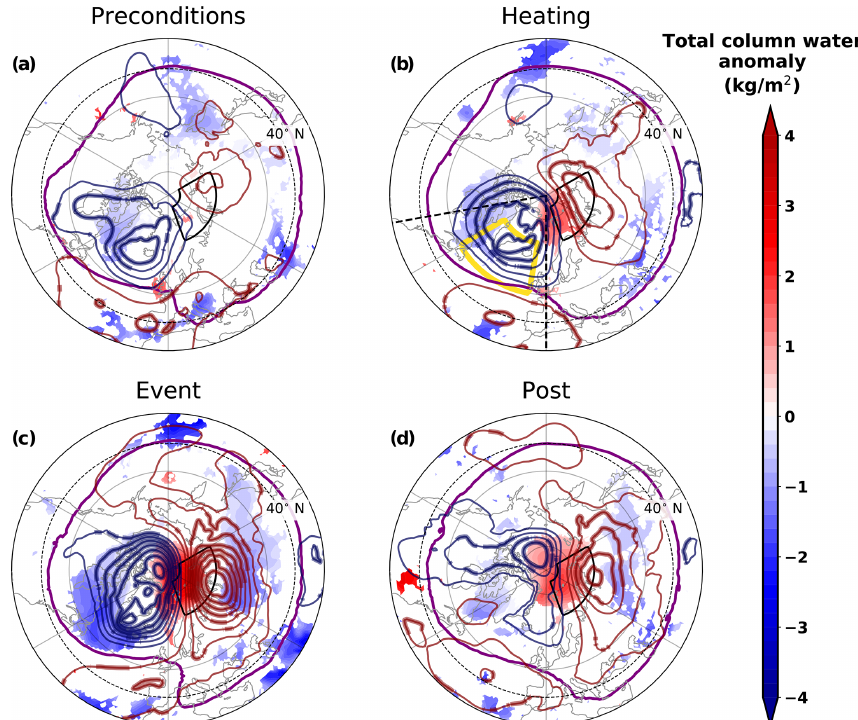
Figure 15. Chain of processes related to Ural warm events as time and event composite during four identified time periods: at preconditions (days − 9 to − 6 relative to trajectory initialization, 3d per event) (a) , at heating ( − 6 to − 1d with respect to trajectory initialization, 5d per event) (b) , in the close vicinity of the warm events (days between lag − 1d relative to trajectory initialization until the peak of warm event, 2–4d per event) (c) and at post conditions (up to 3d after each warm event, 3d per event) (d) . Significant total column water anomalies shown in shading (kgm − 2 , significant when > 67% of the 30 members obtain the same sign in the anomaly as the composite mean), overlaid with SLP anomalies (hPa, every 5hPa, significant in bold contours, red for positive, blue for negative anomalies, zero anomaly contour not shown) and potential temperature on the 2pvu surface (purple solid isoline for 310K). The black dashed region in panel (b) denotes the main heating region, the yellow sector in panel (b) the cyclone region and the dashed black circle shows the latitude band at 40 ◦